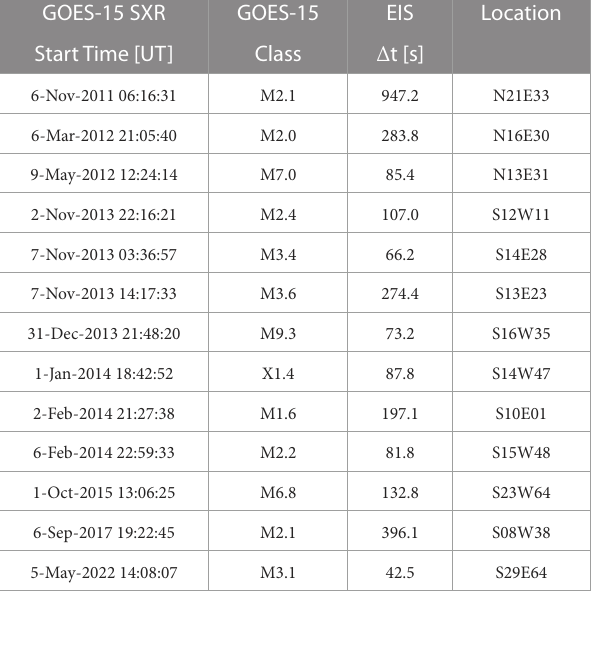
TABLE1 GOES-15starttimeandclassarederivedfromthe2 shighcadence 1.0–8.0Å data. Δ tisthetimedelaybetweentheGOES-15starttimeandthe EFTresponse.LocationsaretakenfromtheHinodeFlareCatalog.